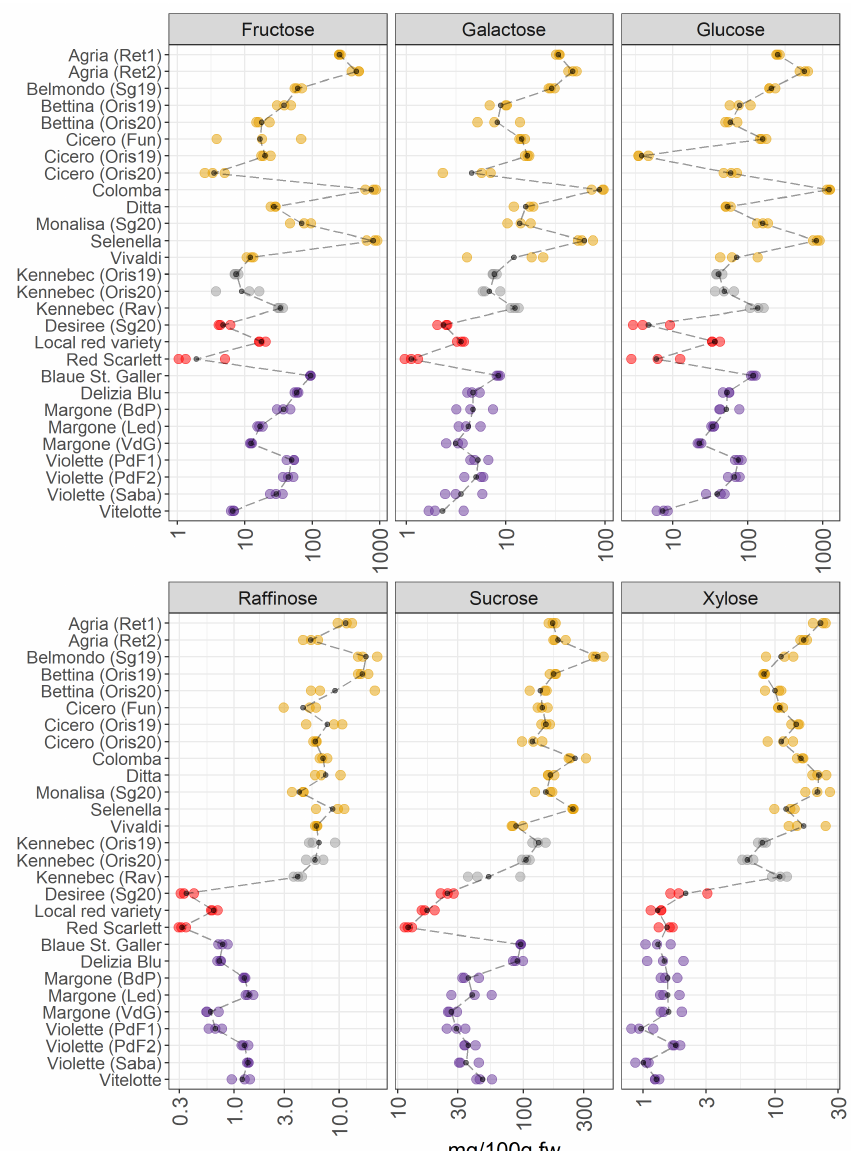
Figure 5. Content of individual sugars in 28 potato samples organized in four groups (yellow-, white-, red-skinned, and purple-fleshed); three biological replicates for each sample were analyzed. The black points represented the averages for each analyte calculated on three biological replicates. The black long dash lines showed the concentration trends amongst all the potato groups. The concentrations were transformed in a log-10-scale. fw = fresh weight. For more detailed information about potato varieties see Table